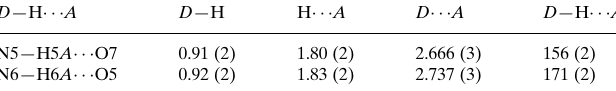
Hydrogen-bond geometry (A˚ , (cid:4)